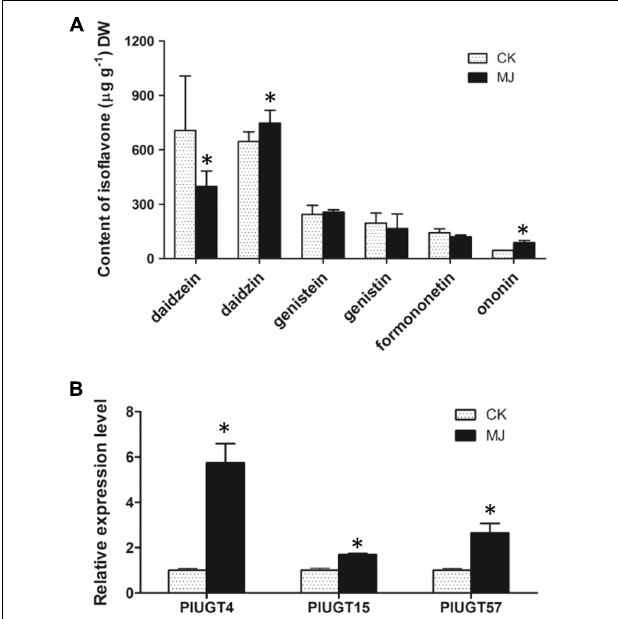
FIGURE 5 | The isoflavone contents and the expression levels of PlUGTs in Pueraria lobata . Two weeks old seedlings with similar growth height were selected for treating with 100 µ M (final concentration) of methyl jasmonate (MJ) for 7 days. CK indicates the mock control plants that were treated with the equal amount of menthol (0.001%, v/v) for the same period. (A) The isoflavone contents were analyzed by HPLC as described in the Section “Materials and Methods.” (B) The expression levels of PlUGTs were monitored by qRT-PCR using the actin gene as the reference standard. Data expressed as means ± SD from three to five biological replicates. ∗ Indicates there is a significant difference between MeJA-treated plants and mock controls ( p <